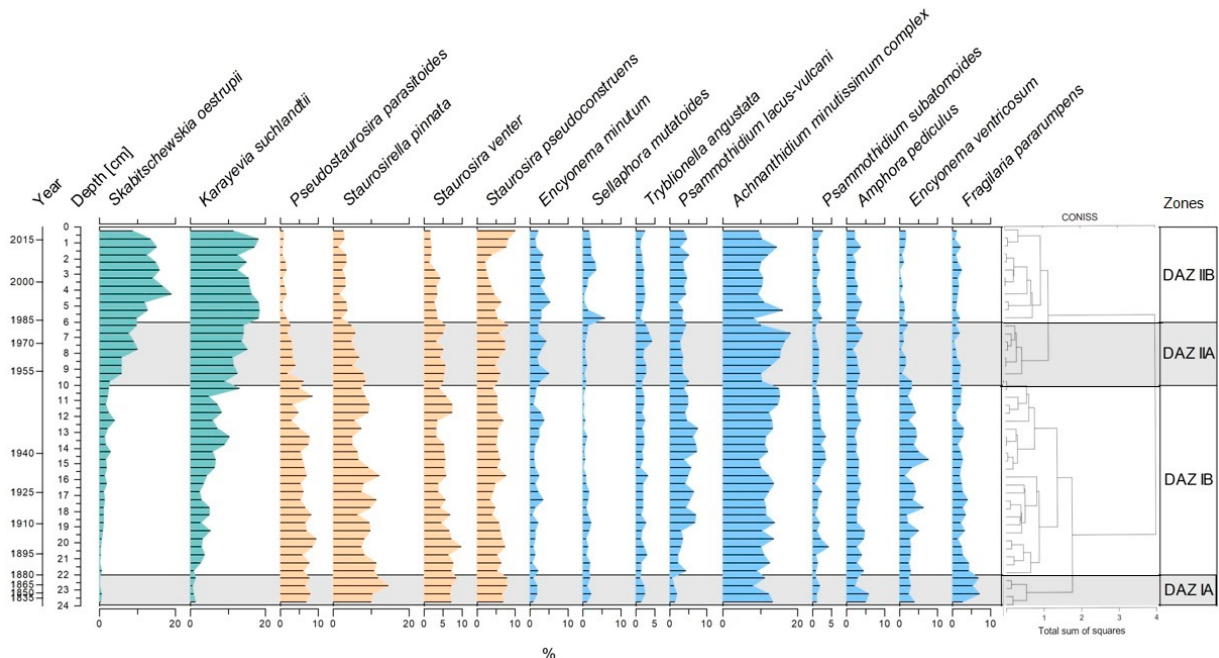
Figure 6. Diatom stratigraphy of the dominant taxa (>5%) in the VRP sediment core. Colours represent: ■ taxa with increasing relative abundance towards the sediment surface, ■ taxa with decreasing relative abundance towards the sediment surface, ■ other species.